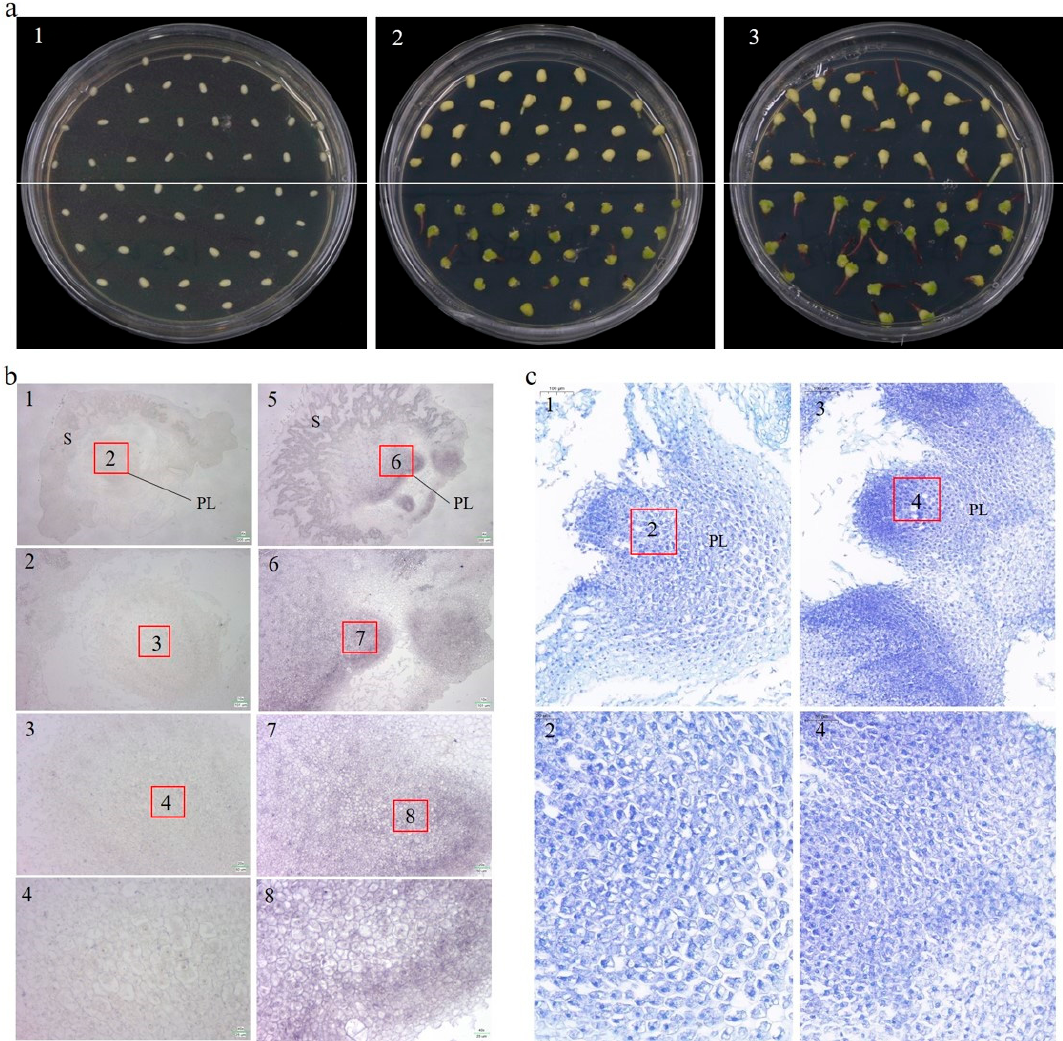
Figure 3. ( a ) Germination of OE49 and WT embryos on MS medium. ( a1 – a3 ). Germination of embryos after 0 days, 7 days and 10 days. WT and OE49 embryos are above and below the white line. ( b ) In situ hybridization of embryos after 10 days of culture on medium. ( b1 – b4 ) The wild-type embryo. ( b5 – b8 ) the OE49 embryo. The scales for b1 to b4 (and b5 to b8) are 205, 101, 50, and 25 µm, respectively. ( c ) Toluidine blue staining of embryos after 10 days of culture on medium. ( c1 , c2 ) The wild-type plumule. ( c3 , c4 ) The OE49 plumule. The scales for c1 and c2 (also c3 and c4) are 100 and 50 µm, respectively. PL: plumule; S: scutellum.